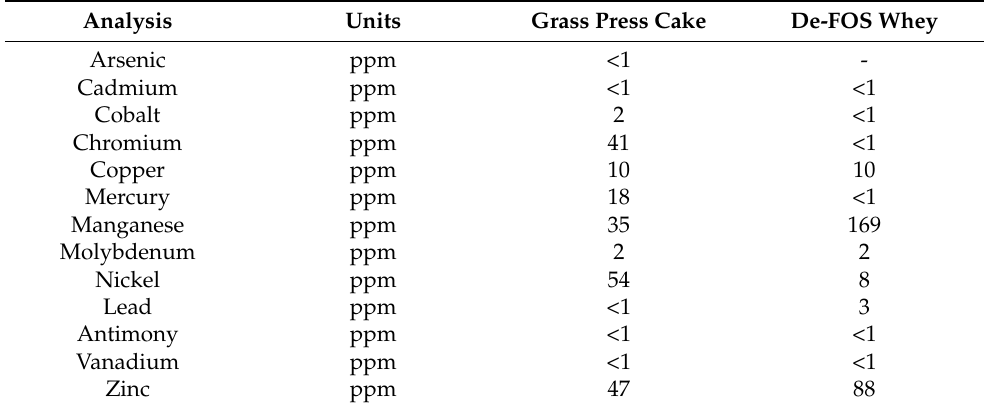
Table 2. Concentration of trace elements in biorefinery